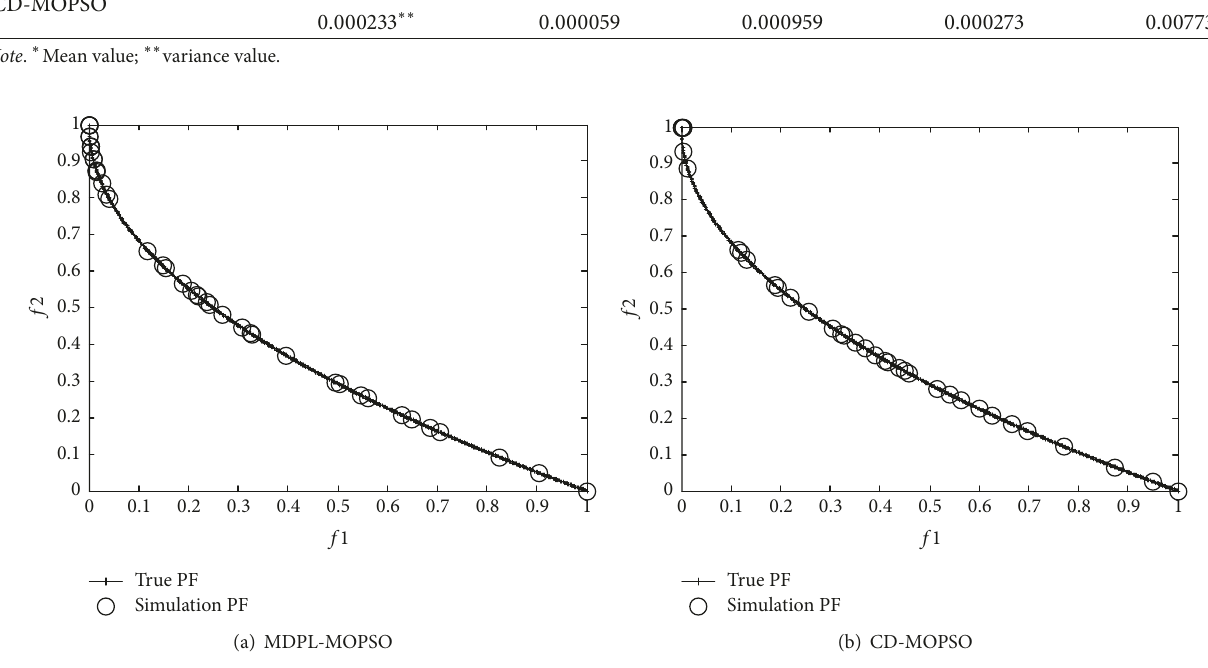
Figure 8: Nondominated solutions with MDPL-MOPSO and CD-MOPSO on